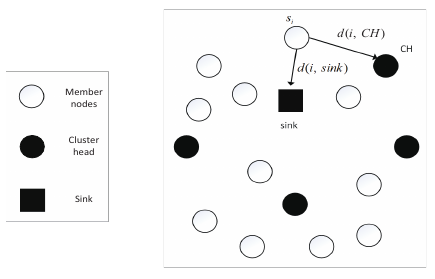
Figure 4. Cluster